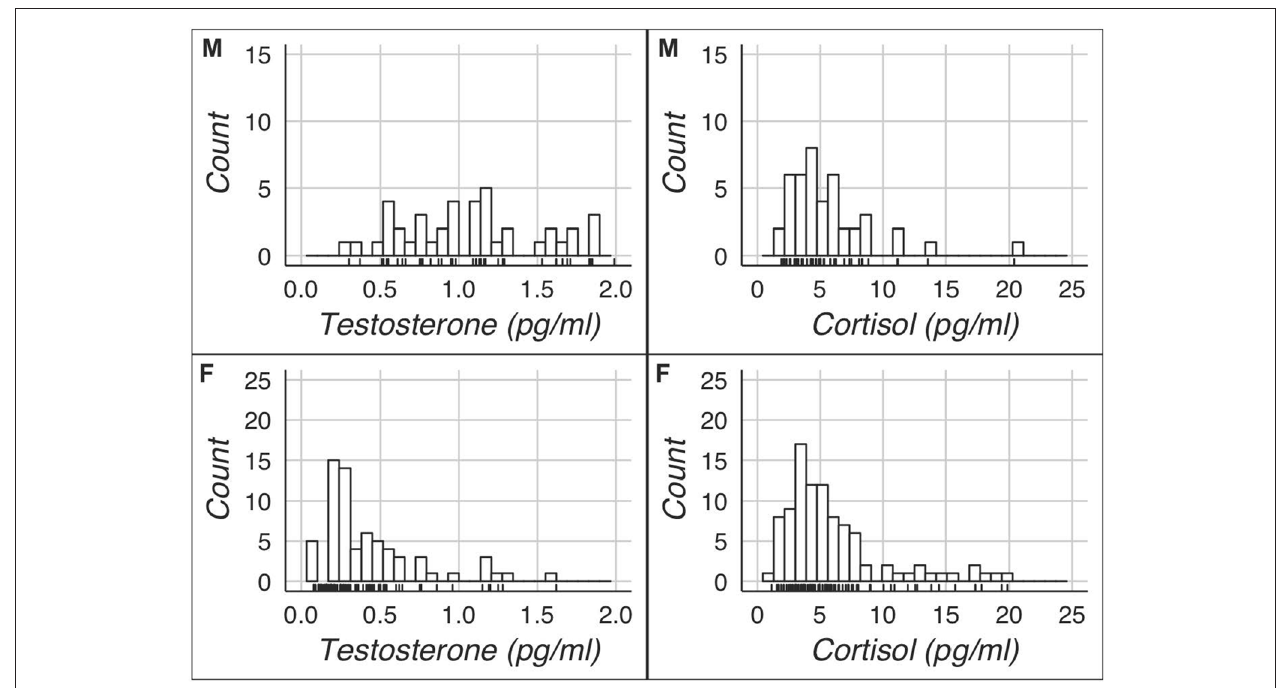
FIGURE 1 | Hormonal distributions of men (M) and women (F).